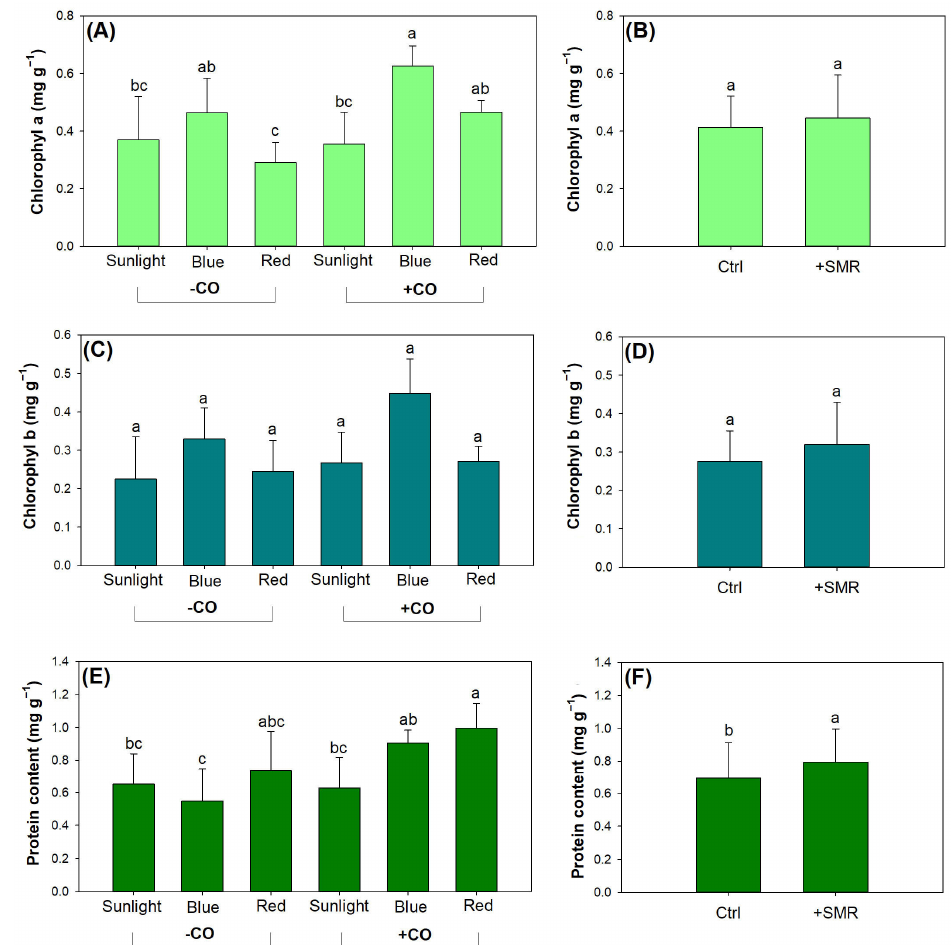
Figure 5. Leaf chlorophyl and protein contents in black chokeberry ( Aronia melanocarpa (Michx.) Elliott 1821) exposed to combined light-type (sunlight, blue light-emitting diode (LED), red LED), chitosan oligosaccharide (CO), and spent mushroom residue (SMR) treatments: ( A ) combined CO and light effects on chlorophyl a content; ( B ) SMR effect on chlorophyl a content with unamended soils as the control (Ctrl); ( C ) combined CO and light effects on chlorophyl b content; ( D ) SMR effect on chlorophyl b content with unamended soils as the control (Ctrl); ( E ) combined CO and light effects on protein content; ( F ) SMR effect on protein content with unamended soils as the control (Ctrl). Different letters mark significant difference according to Tukey test at 0.05 level.